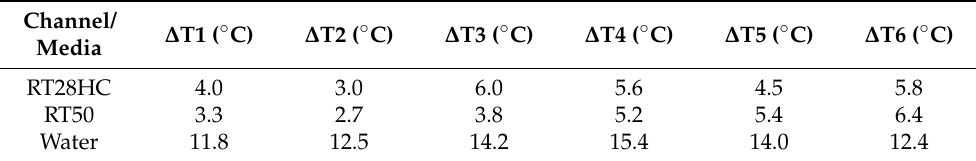
Table 4. Maximum, minimum, and average temperatures across the channels during the end of the experiment.